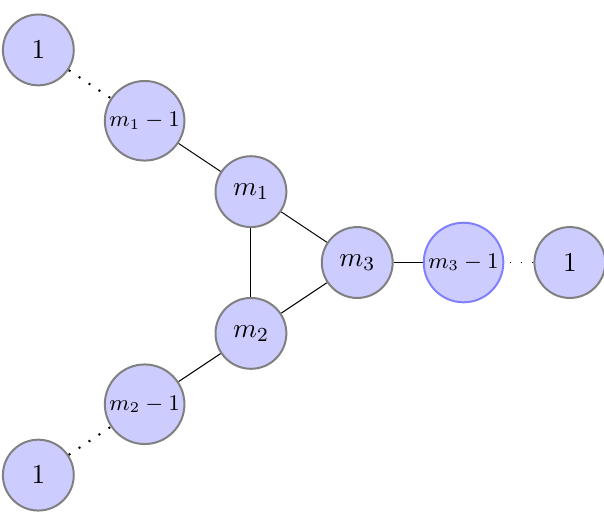
Figure 14 . The 3D mirror of the S 1 reduction of the T 2 ; AD SCFT. Nodes and lines are ( m 1 ;m 2 ;m 3 ) de(cid:12)ned as in (cid:12)gure 11. The three U( m i ) (cid:2) (cid:1) (cid:1) (cid:1) (cid:2) U(1) quiver tails generate independent SU( m i ) fugacities and correspond to the independent SU( m i ) parts of the three TQFT wave functions. On the other hand, the U(1) parts of the three TQFT wave functions are symmetrically dependent. This dependence is re(cid:13)ected in the quiver by the loop of three U( m i ) nodes.